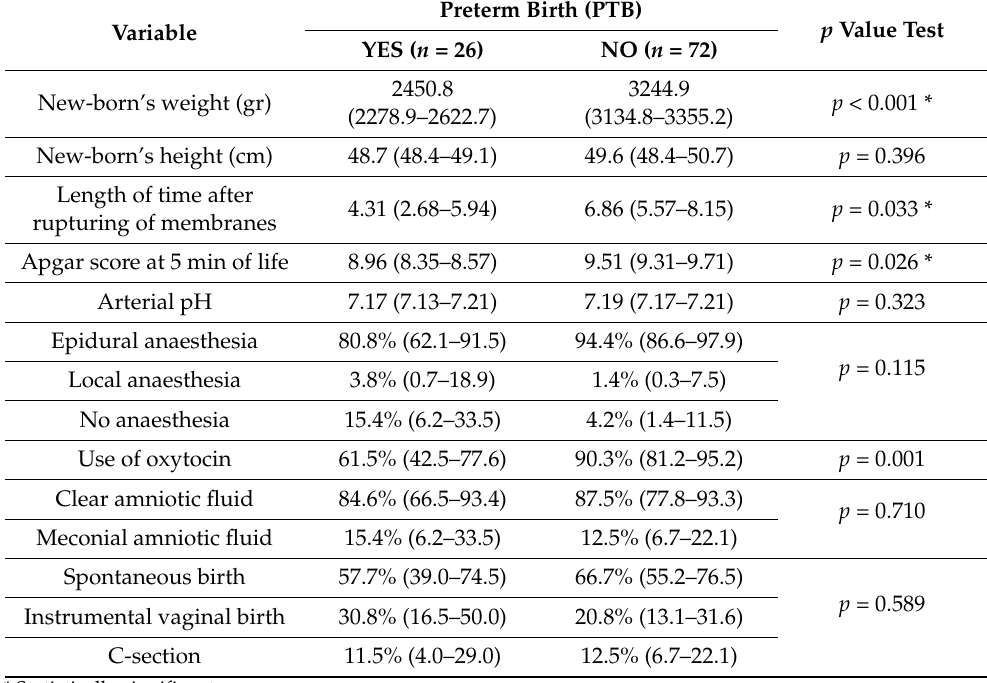
Table 2. Variables related with childbirth according to preterm birth